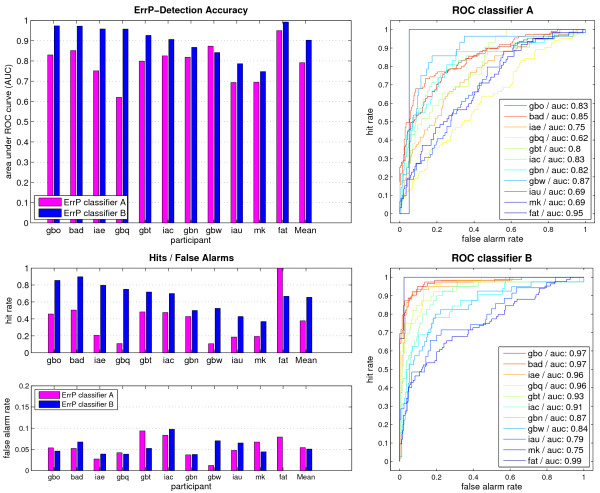
ErrP Classification. Performance of the online ErrP classifiers. The AUC for each participant and for the mean are depicted in the top left plot for classifier A (magenta) and classifier B (blue). The hit rates and false alarm rates for each participant and classifier are shown underneath. The right plots show the ROC curves of each participant for classifier A (top) and classifier B (bottom). Classifier B has higher AUCs in all but one participant. The mean AUCs differ more than 10%. This can also be seen in the ROC curves, which reach higher hit rates at lower false alarm rates for classifier B. False alarm rates could be kept around 5% in most participants. In two participants, the false alarm rate approached 10%.